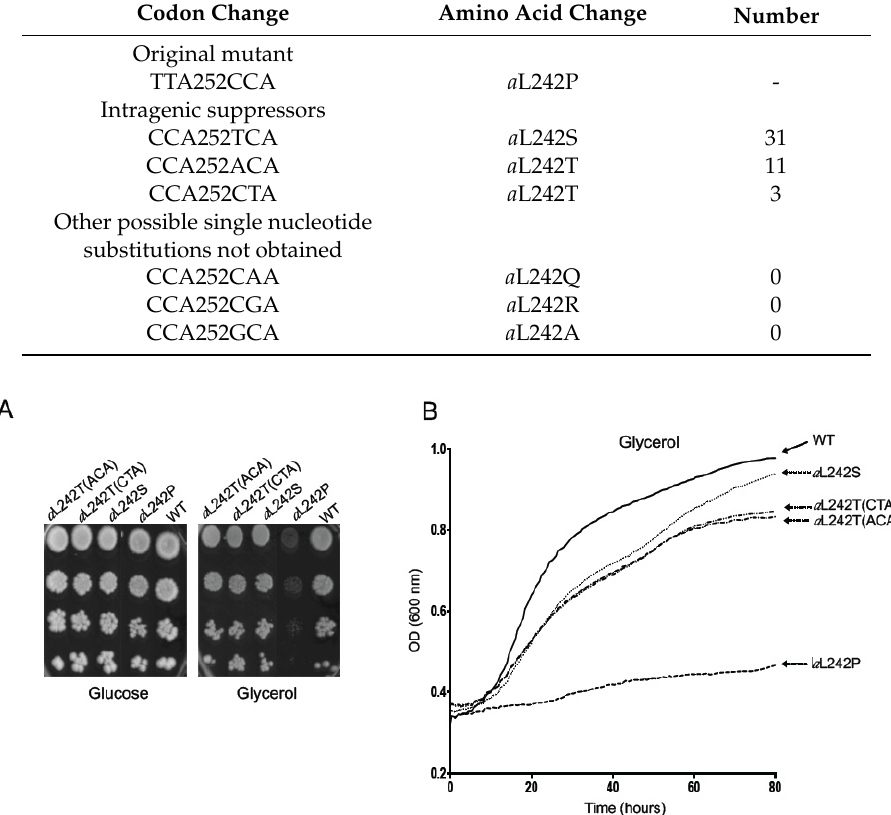
Figure 1. Respiratory growth of yeast strains. ( A ) Fresh glucose cultures of wild type yeast ( WT ), and the mutant strains a L242P, a L242T and a L242S were serially diluted and spotted onto rich glucose and glycerol plates. The shown plates were scanned after 4 days incubation at 28 °C. ( B ) Growth of the same strains in liquid glycerol medium monitored with the Bioscreen system over a period of 80 h during which cell densities (OD 600nm ) were taken every 20 min.